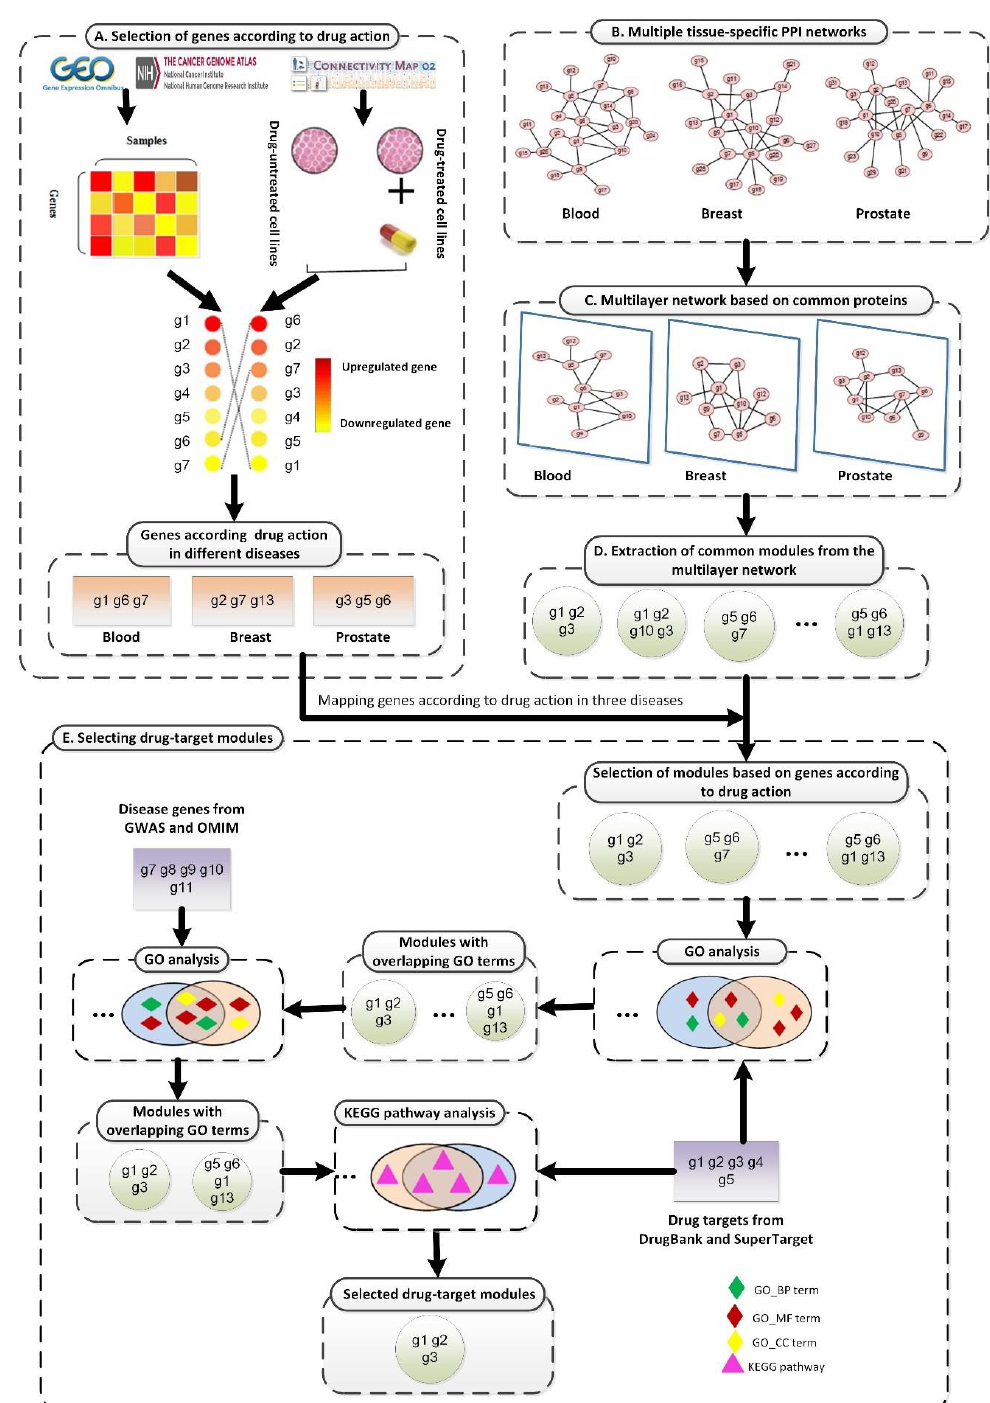
Figure 1. The framework of the proposed SDTP method. ( A ) Selection of genes according to TSA activity in three diseases based on gene differential expression profiles. ( B ) Processing of TSPPI networks related to the three diseases from the GIANT database. ( C ) Standardization of a multilayer subgraph based on common proteins obtained from ( B ). ( D ) Use of the tensor-based mining algorithm to identify drug-target modules from the multilayer TSPPI network. ( E ) Selection and validation of drug-target modules.